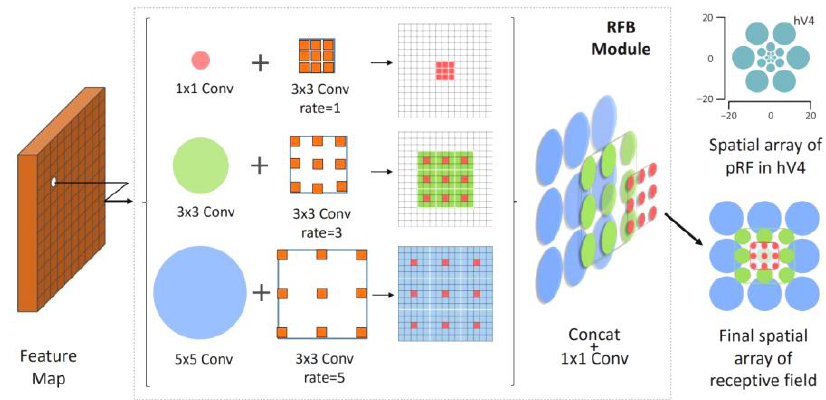
Figure 5. Mixed enhanced receptive field.